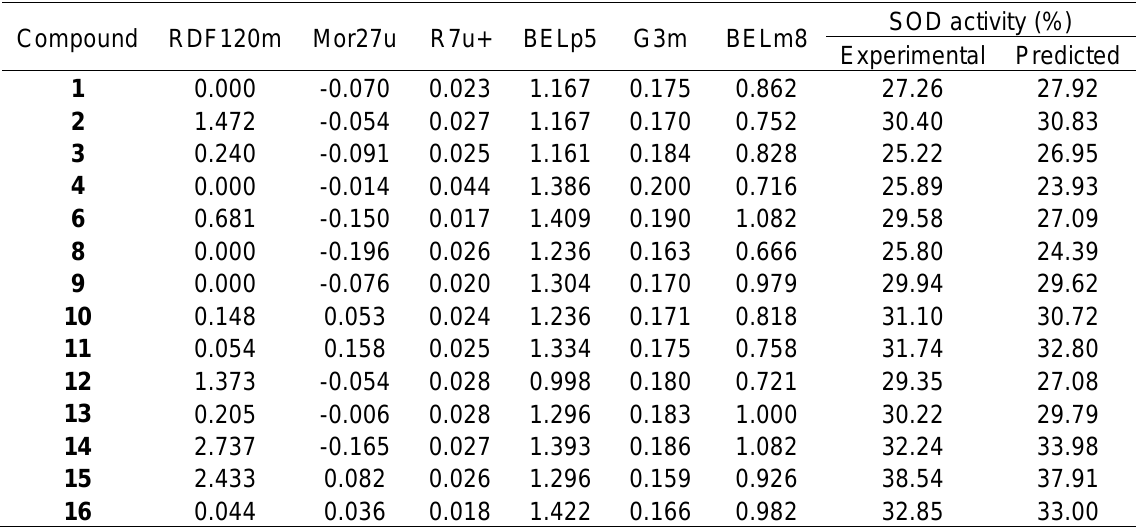
Table 5: Values of molecular descriptors and predicted SOD activity of sulfonamides